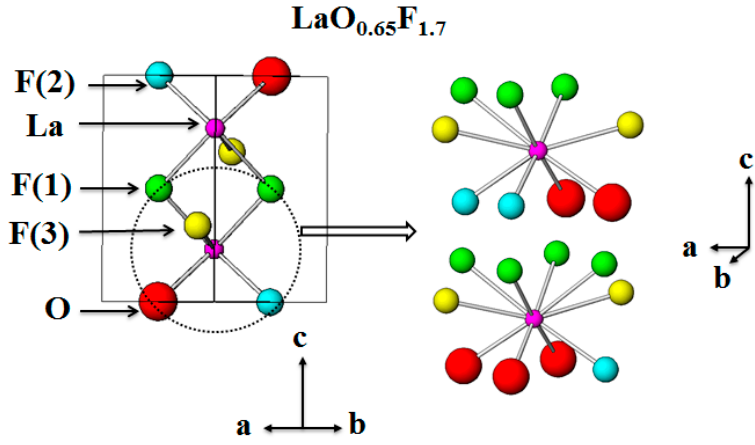
Figure 1. The structure of tetragonal LaO 0.65 F 1.7 host lattice.